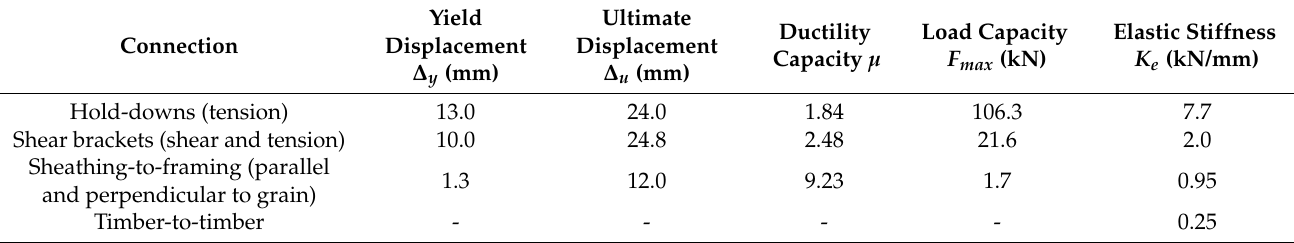
Table 2. General mechanical properties of connections in the